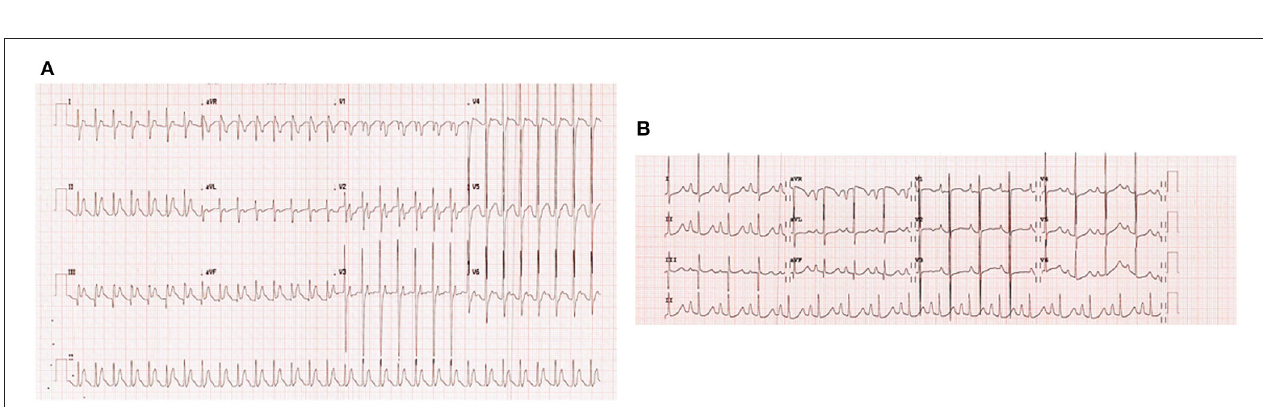
FIGURE 2 | Echocardiography of patient #1 prior to treatment with ivabradine. (A) A moderate mitral regurgitation and a severely dilated left ventricle were observed on echocardiography. (B) Liver ultrasound revealed dilated inferior vena cava and hepatic veins.